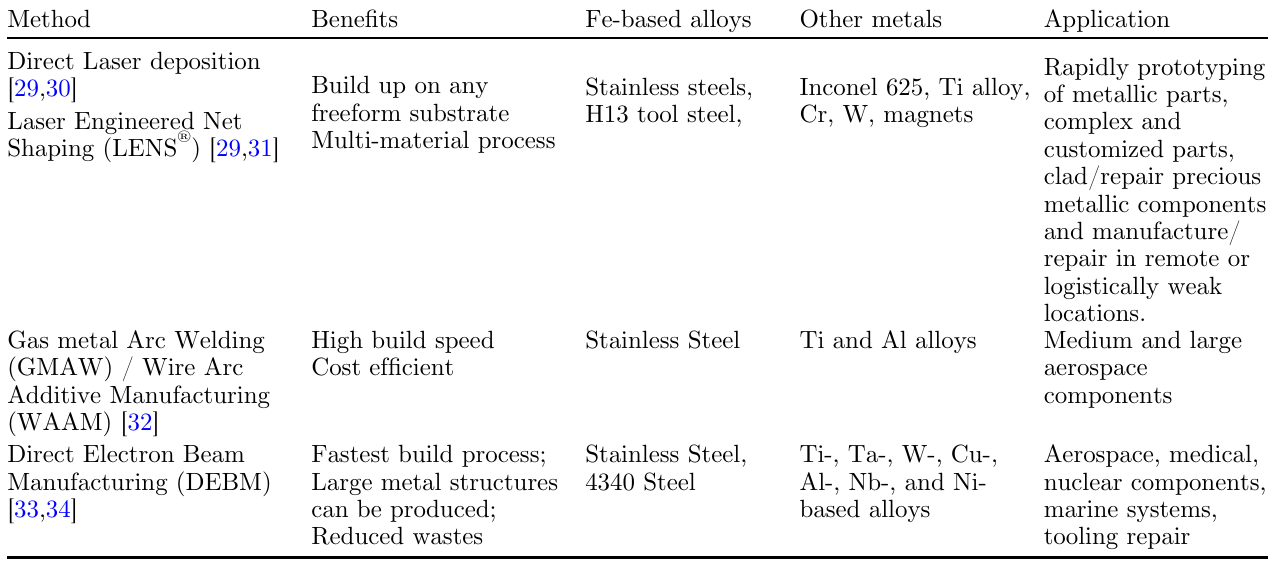
Table 2. Direct Energy Deposition techniques.